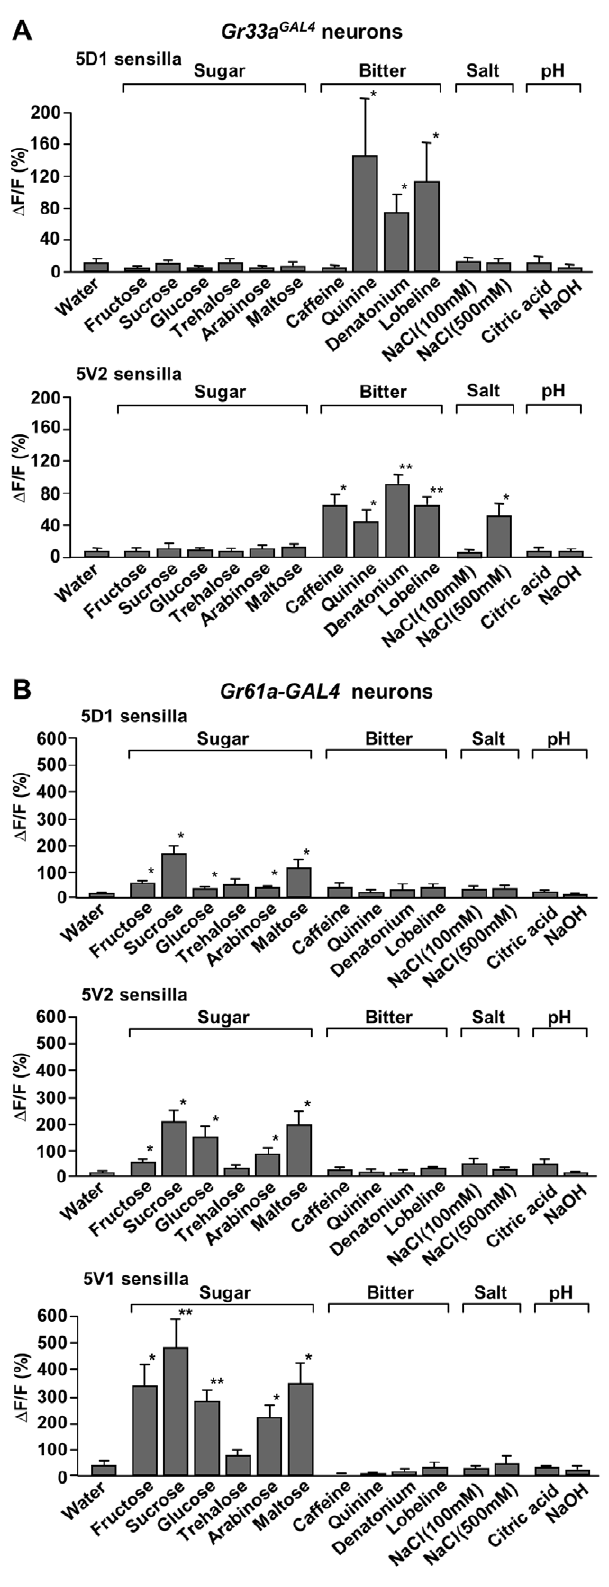
Figure 3. Subtypes of neurons within a taste modality show different response profiles. Ca 2 + responses of Gr33a GAL4 (A) and Gr61a-GAL4 expressing neurons, stimulated by various sugars, bitter compounds, low (100 mM) and high (500 mM) NaCl, acidic (citric